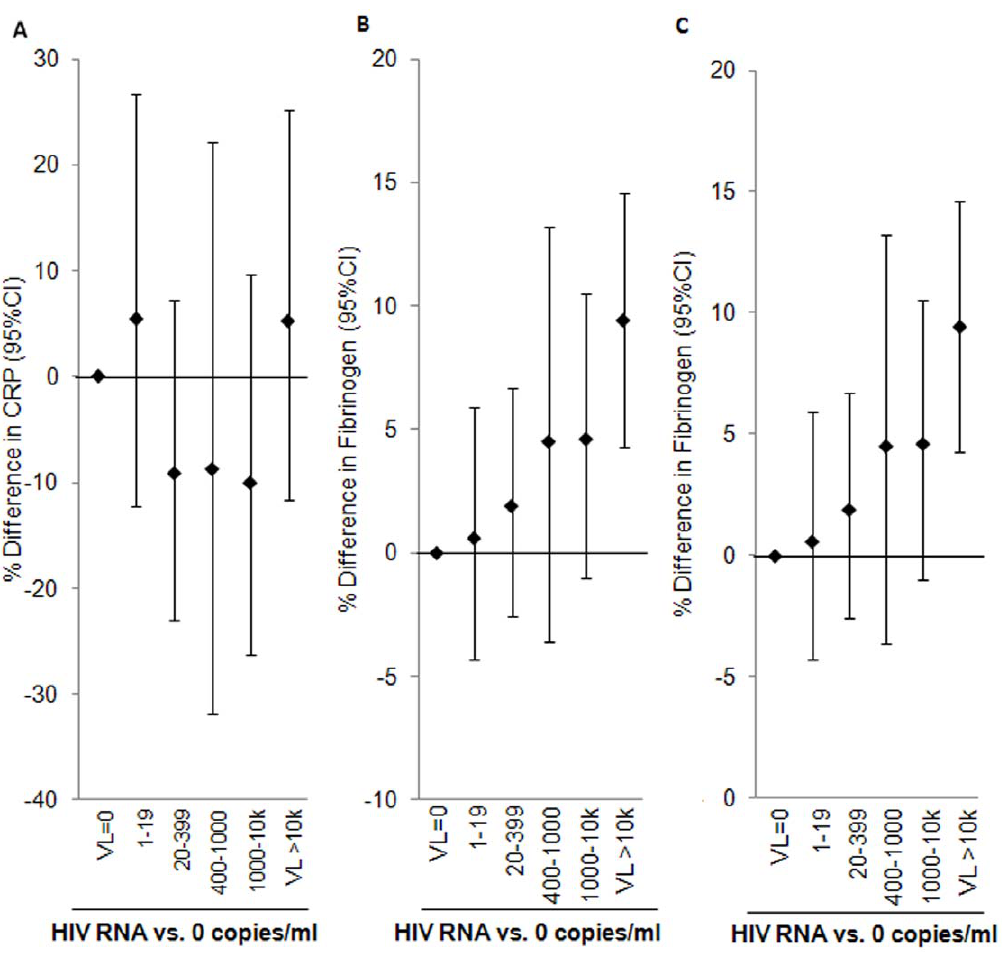
Figure 1. Multivariable-adjusted association of HIV RNA with (A) CRP*, (B) IL-6 { , (C) fibrinogen ¥ . * (A) Estimates from multivariable- adjusted model controlling for gender, age, race, smoking, physical activity, VAT, Arm SAT, nadir CD4, and HCV status. { (B) Estimates from multivariable-adjusted model controlling for gender, age, race, smoking, and current CD4. ¥ (C) Estimates from multivariable-adjusted model controlling for gender, age, race, smoking, alcohol, upper trunk SAT, nadir CD4, HIV duration, and HCV status.